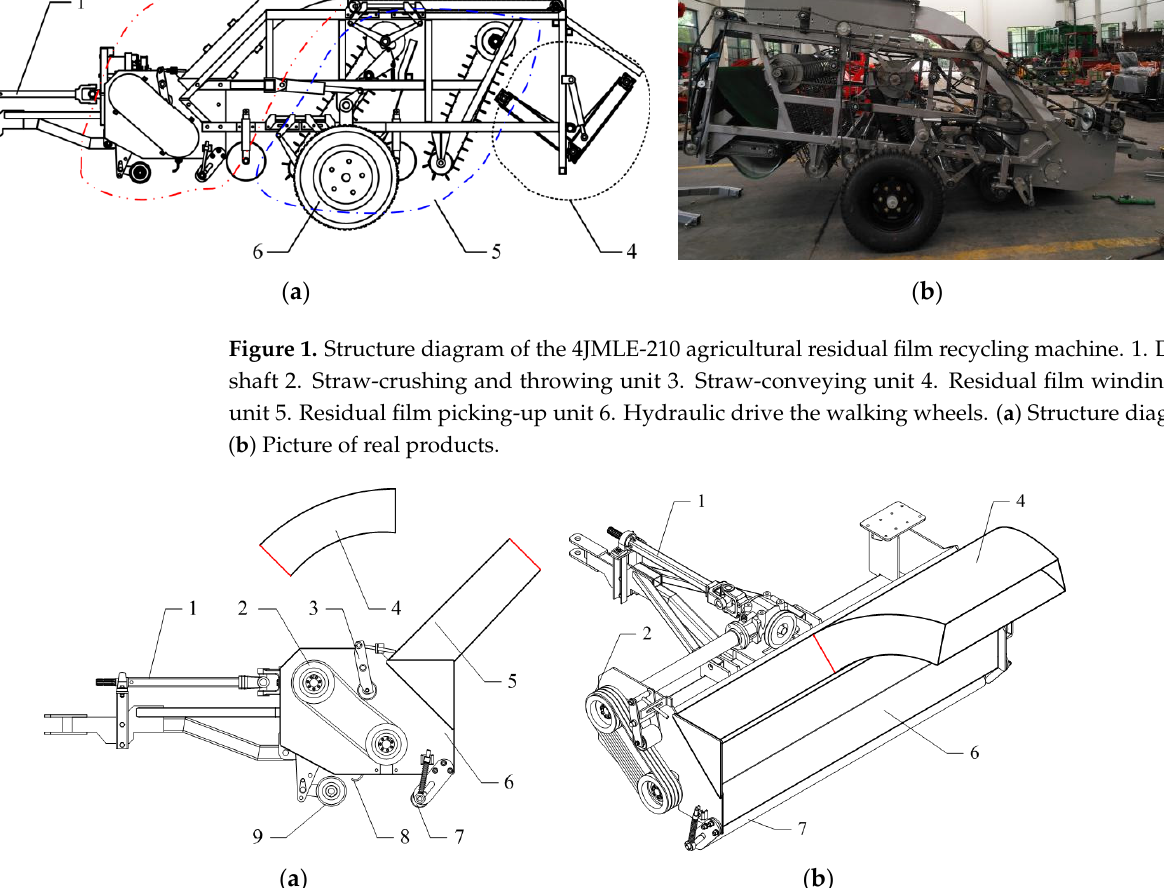
Figure 2. Structure diagram of straw-crushing, throwing, and returning device. 1. Drive shaft 2. Belt transmission 3. Tensioning mechanism 4. Throwing arc. 5. Straight pipe. 6. Crushing chamber 7. Post press film roller 8. Knife set 9. Front press film roller. ( a ) Main view. ( b ) Axonometric